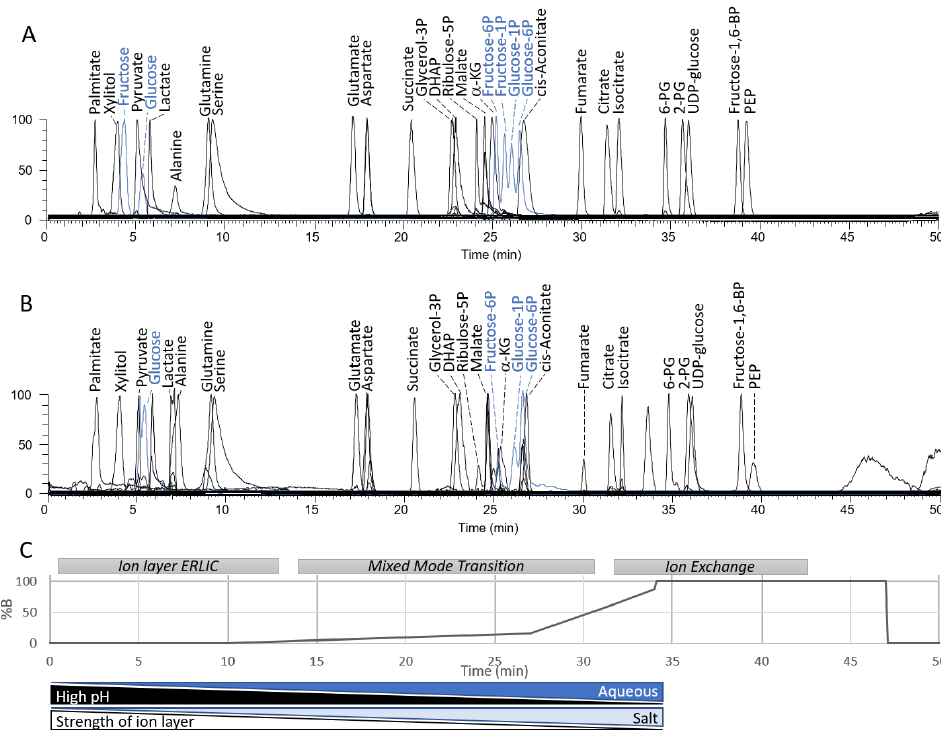
Figure 1. Mixed mode chromatographic resolution of central carbon metabolites ( A ) Extracted Ion Chromatograms (EICs) of standards from central carbon metabolism. ( B ) EICs of the same metabolites from mouse heart. ( C ) Schematic showing MM chromatographic segments and gradient. Applied to a positively charged quaternary amine polyvinyl alcohol stationary phase, Buffer A consists of 90% acetonitrile and 10% water, containing 20 mM Triethylamine: Formic acid at pH 9.18. Buffer B consists of 5% acetonitrile and 95% water containing 54 mM Triethylamine: Formic acid at pH 3.03. Abbreviations: P phosphate; BP bisphosphate, DHAP dihydroxyacetone phosphate; αKG α -ketoglutarate or 2-oxoglutarate; 2PG 2-phosphoglycerate; PEP phosphoenolpyruvate, UDP uridine diphosphate.